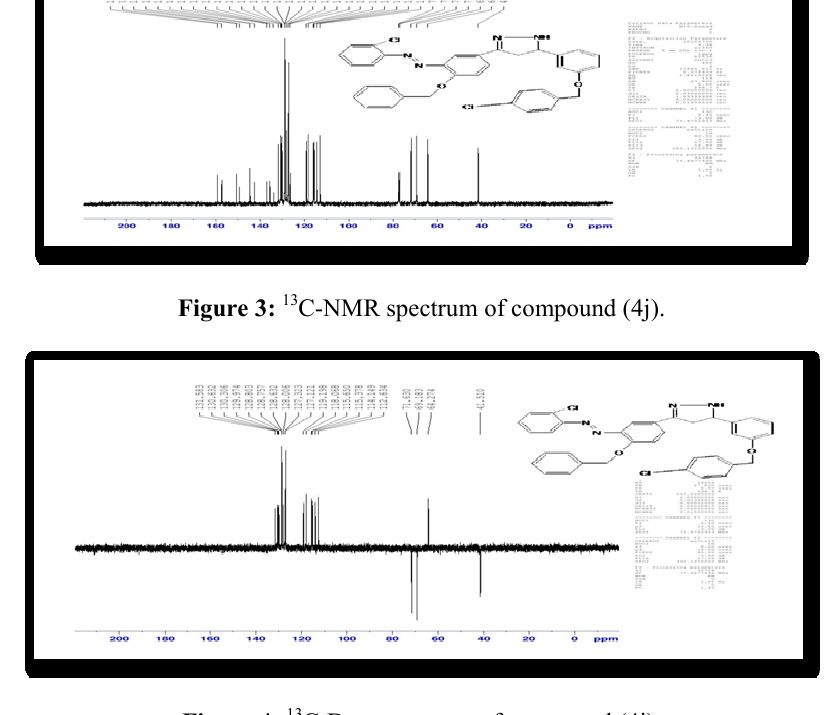
Figure 4: 13 C-Dept spectrum of compound